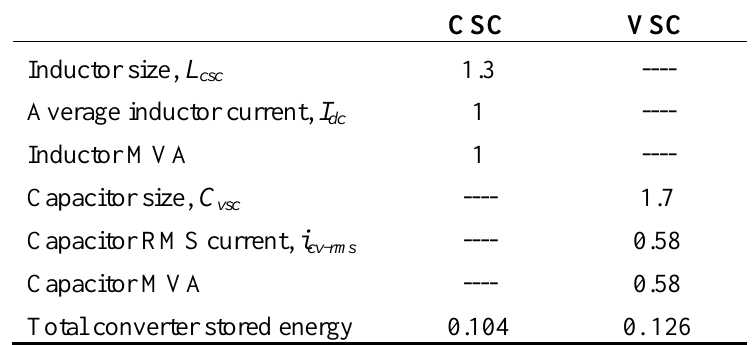
Table 6. Benchmark DC side reactive component summary for CSC & VSC